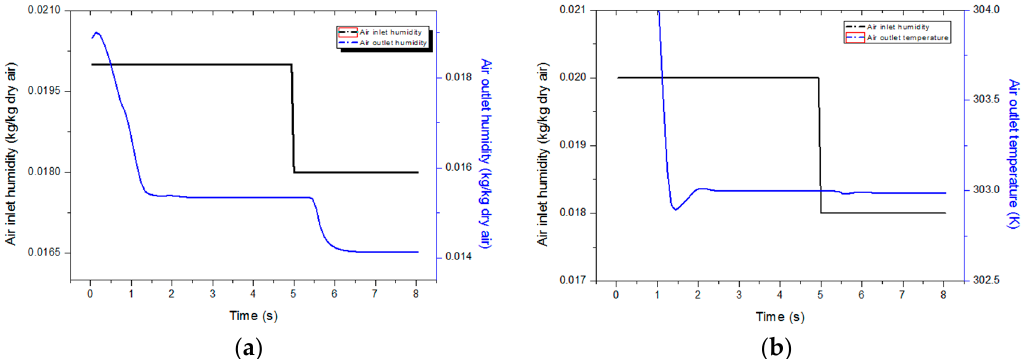
Figure 2. Humidity and temperature variation under step change of air humidity. ( a ) air outlet humidity; ( b ) air outlet